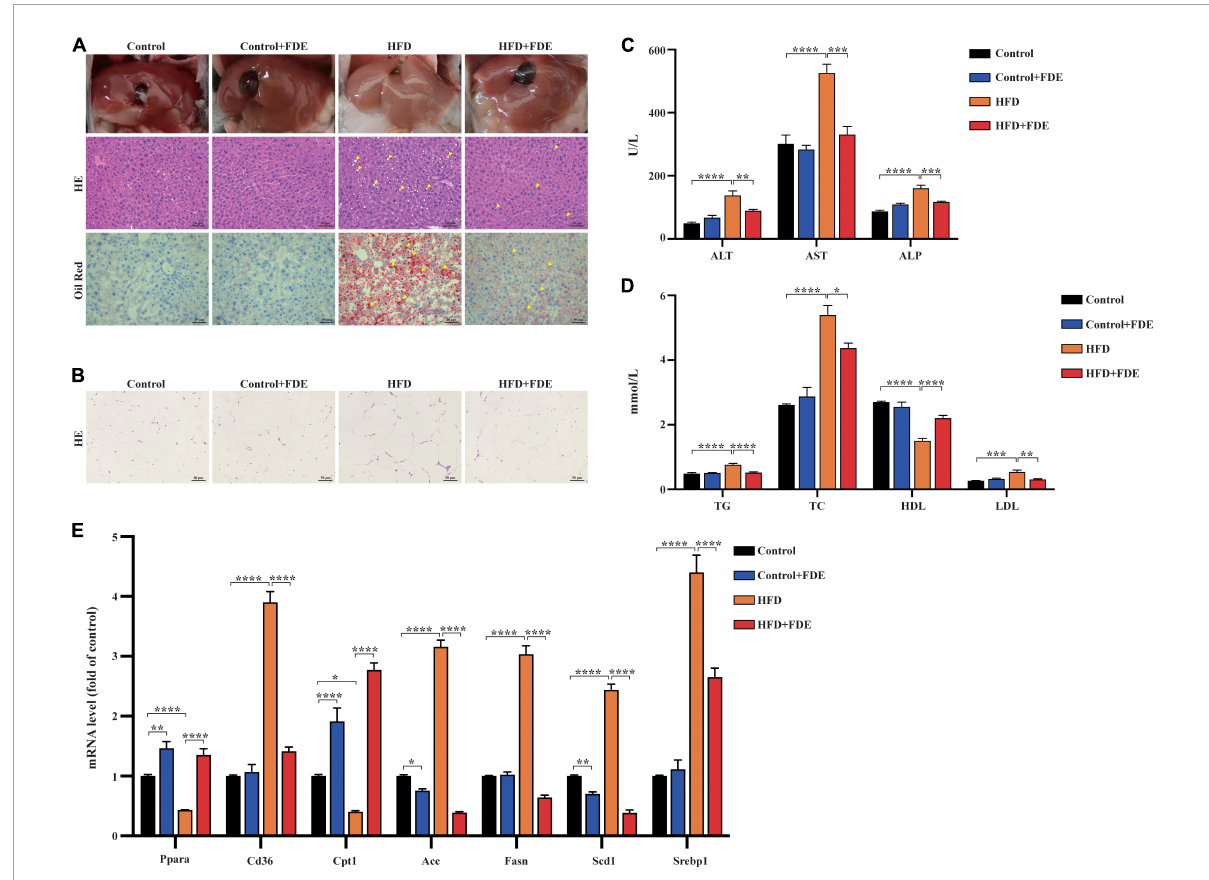
FIGURE2 Effects of FDE on hepatic steatosis and lipid metabolism in HFD-fed mice. (A) Macroscopic image (top), H&E staining (middle), and Oil Red O staining (bottom) of liver sections of the four groups after feeding the respective diets for 14 weeks (magnification 200 × ; scale bar, 50 µ m). The arrows indicate the fat vacuoles or lipid droplets. (B) Representative images of H&E staining of epididymal adipose tissue sections (magnification 200 × ; scale bar, 50 µ m). Serum levels of (C) ALT, AST, ALP and (D) lipids in the four groups at the 14th week. (E) Quantitative real-time PCR analysis of the mRNA levels of lipid metabolism-related genes in the liver tissues. The data were analyzed by one-way ANOVA. All values are presented as the means ± SEM, and n = 3–6 per group. Control, normal diet; HFD, high-fat diet; Control + FDE, a mixture of FDE and normal diet; HFD + FDE, a mixture of FDE and high-fat diet. * P < 0.05, ** P < 0.01, *** P < 0.001, **** P < 0.0001. HFD group versus the control group, HFD + FDE group versus the HFD group, or control + FDE group versus the control